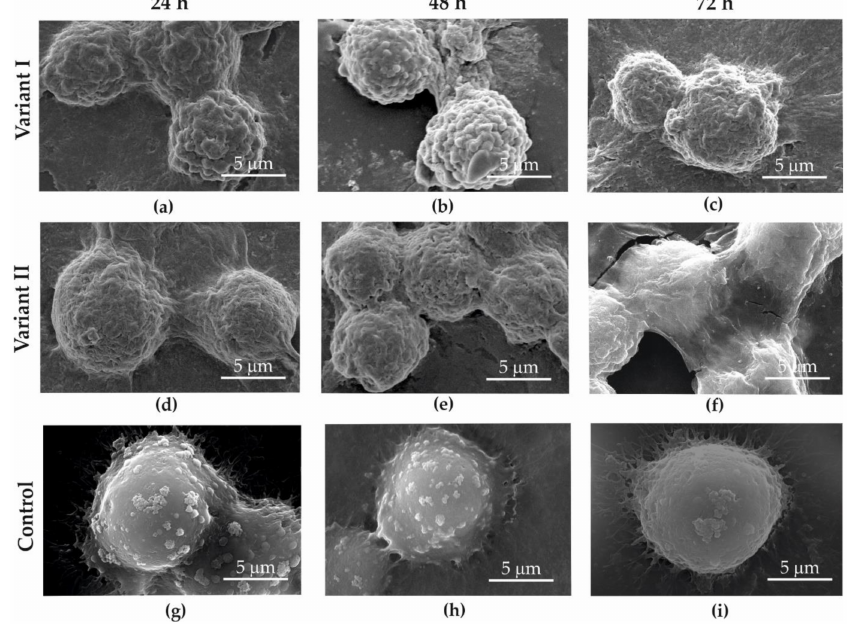
Figure 7. SEM image of MDA-MB-231 cancer cells obtained for variant I ( a – c ); variant II ( d – f ); control ( g – i ); after 24 ( a , d , g ), 48 ( b , e , h ), and 72 h ( c , f , i ). Deformation of the cell membrane was not observed in control samples (control Figures 7g–i and 8g–i), where GO did not interact with the examined cell